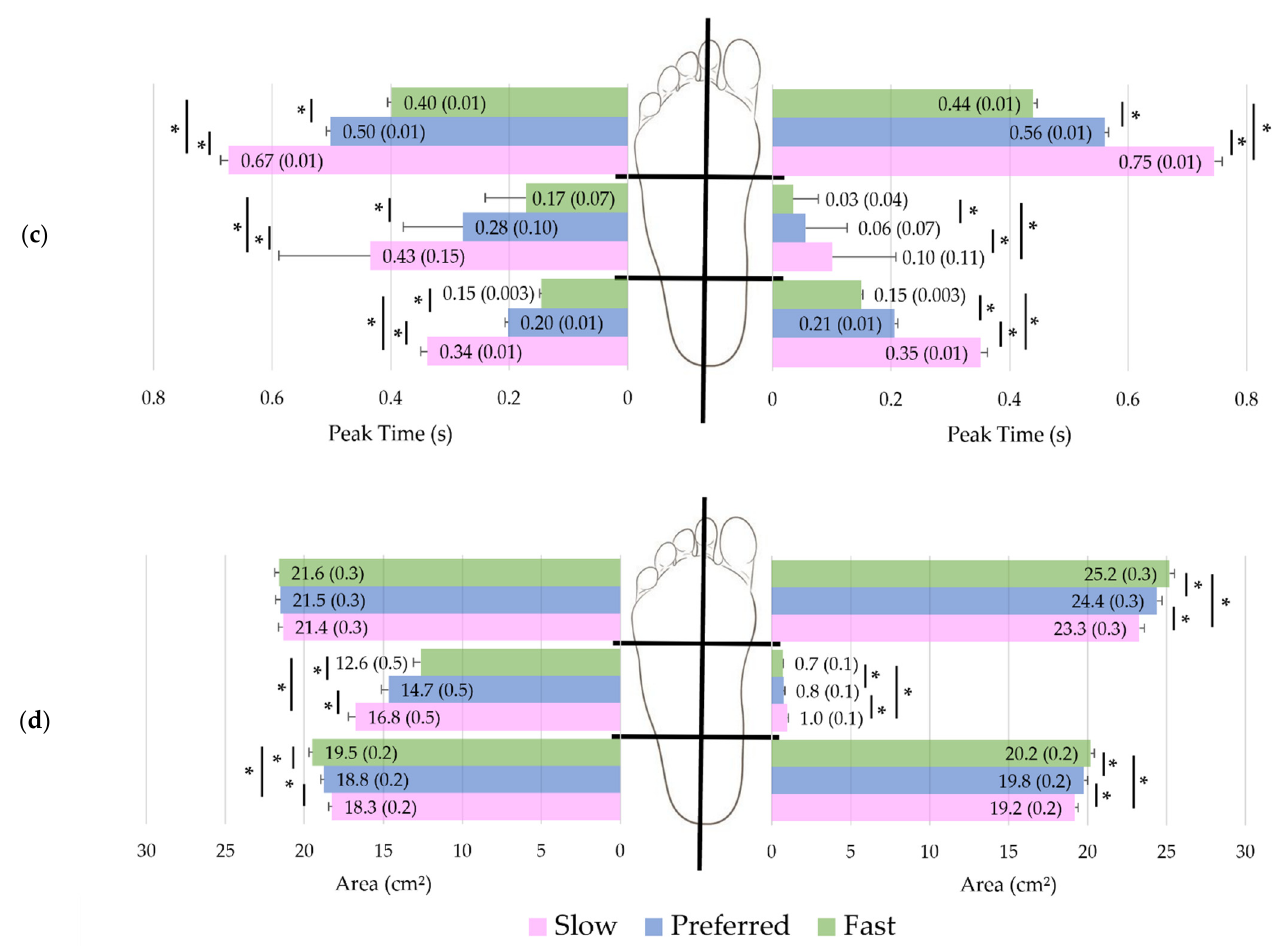
Figure 2. For each define pressure zone, ( a ) Peak pressure, ( b ) P*t, ( c ) Peak time and ( d ) Area mean (and standard errors) [computed for covariates at their means: age = 42.5 yrs] at each specific walking speed (from bottom to top): slow velocity results are in pink, preferred in blue, and fast in green. Results are computed on all subjects ( n = 170). Asterisks (*) denote statistically significant differences between velocities within each plantar pressure zones ( p < 0.05).